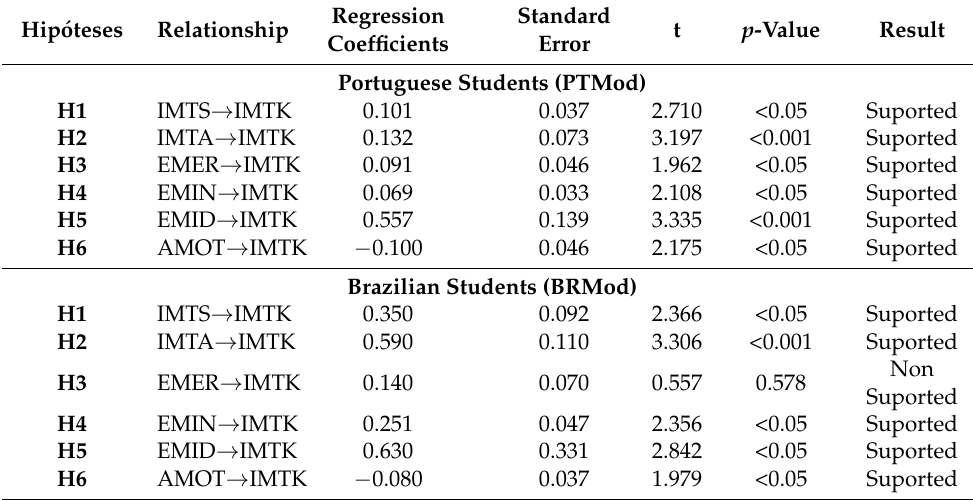
Table 5. Research hypotheses and statistical results–PTMod and